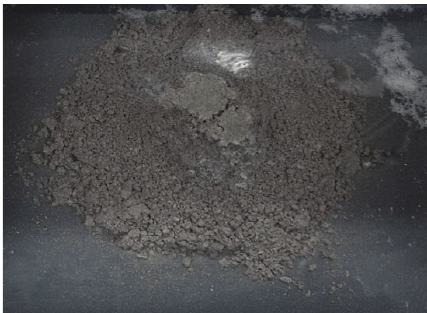
Figure 6: Natural samples disintegrate after 48-hour immersion in